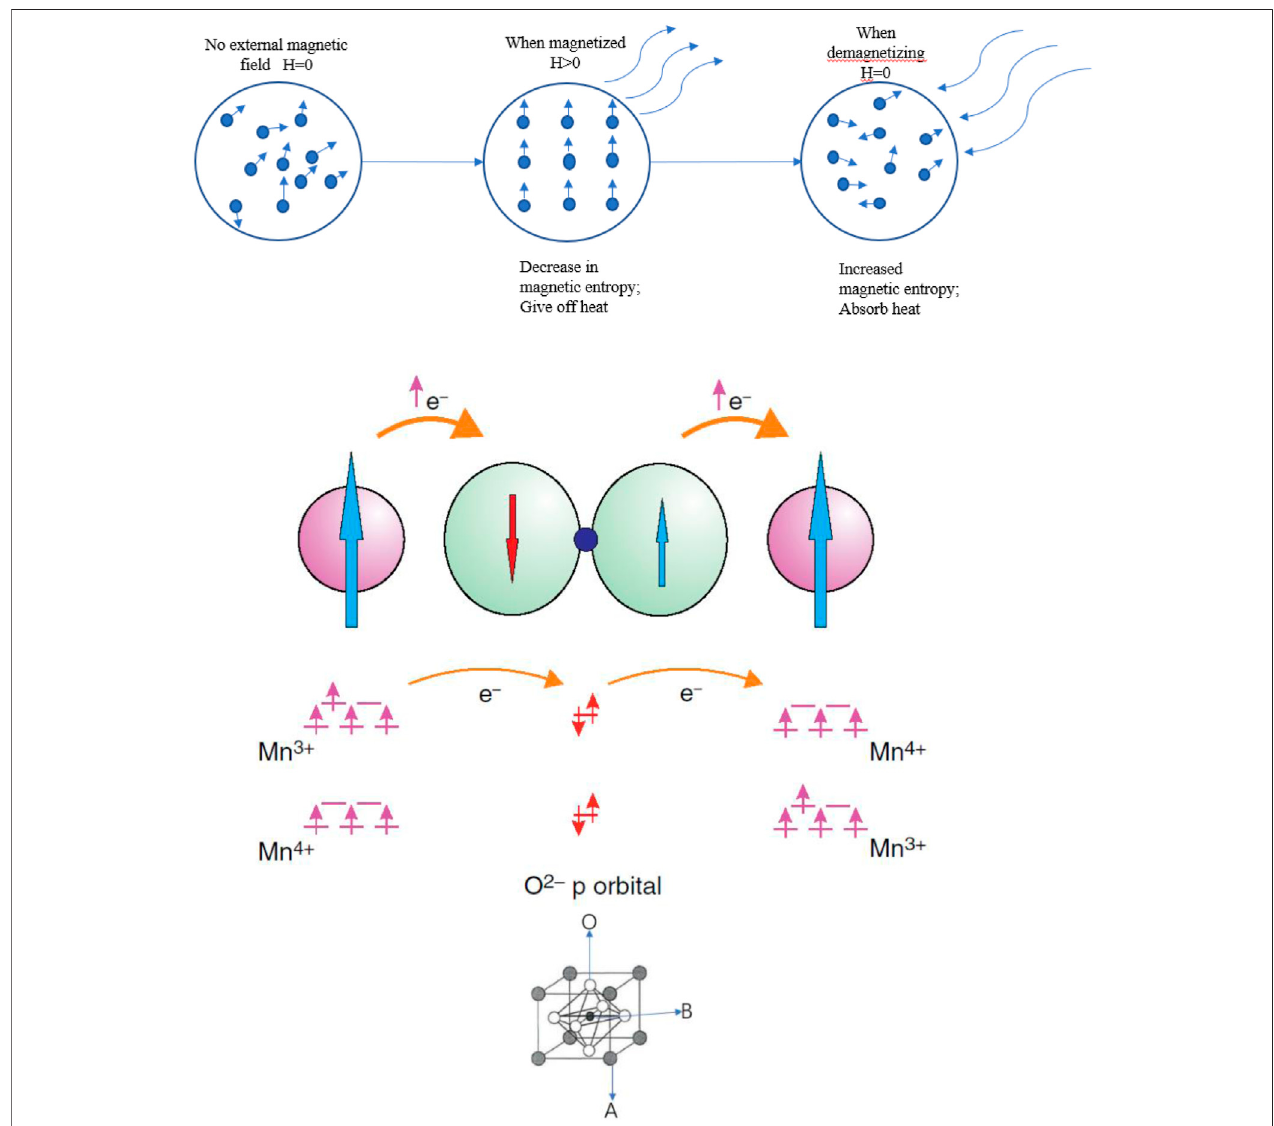
FIGURE 1 | Schematic diagram of magnetic refrigeration, schematic diagram of double exchange mechanism and crystal structure of perovskites (ABO 3 ).